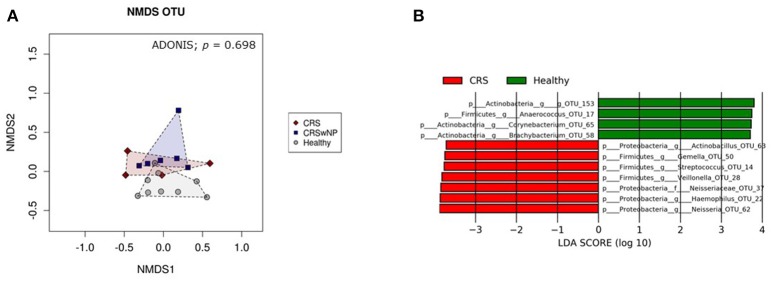
Visualization of bacterial community composition of sinonasal swabs from CRS and healthy individuals. Bacterial 16S rRNA gene data at 97%-OTU level were used to (A) construct an nMDS plot, and (B) investigate potential microbial biomarkers for CRS and healthy individuals using LDA-LeFSe analysis. The nMDS plot and ADONIS analysis showed no significant difference in bacterial community composition between healthy samples (gray circles) and CRS with polyps (CRSwNP) (blue squares) and without polyps (CRS) (red diamonds). Graphs were made using Calypso software. LDA-LeFSe analysis identified seven potential microbial biomarkers of CRS (colored in red) and four potential biomarkers of heathy samples (colored in green). The taxa identified in this plot differed significantly between the two cohorts of this study. The greater the LDA score, the higher the magnitude of difference (reflecting marked differences in abundance) between cohorts.